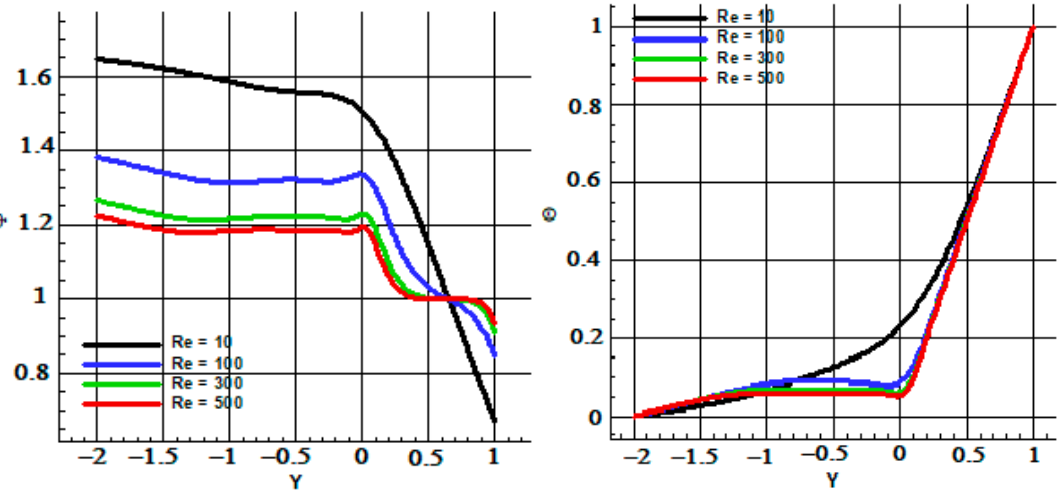
Figure 7. Concentration and temperature for different Re number and Pr = 6.2, Le = 1, N B = N T = 0.1.